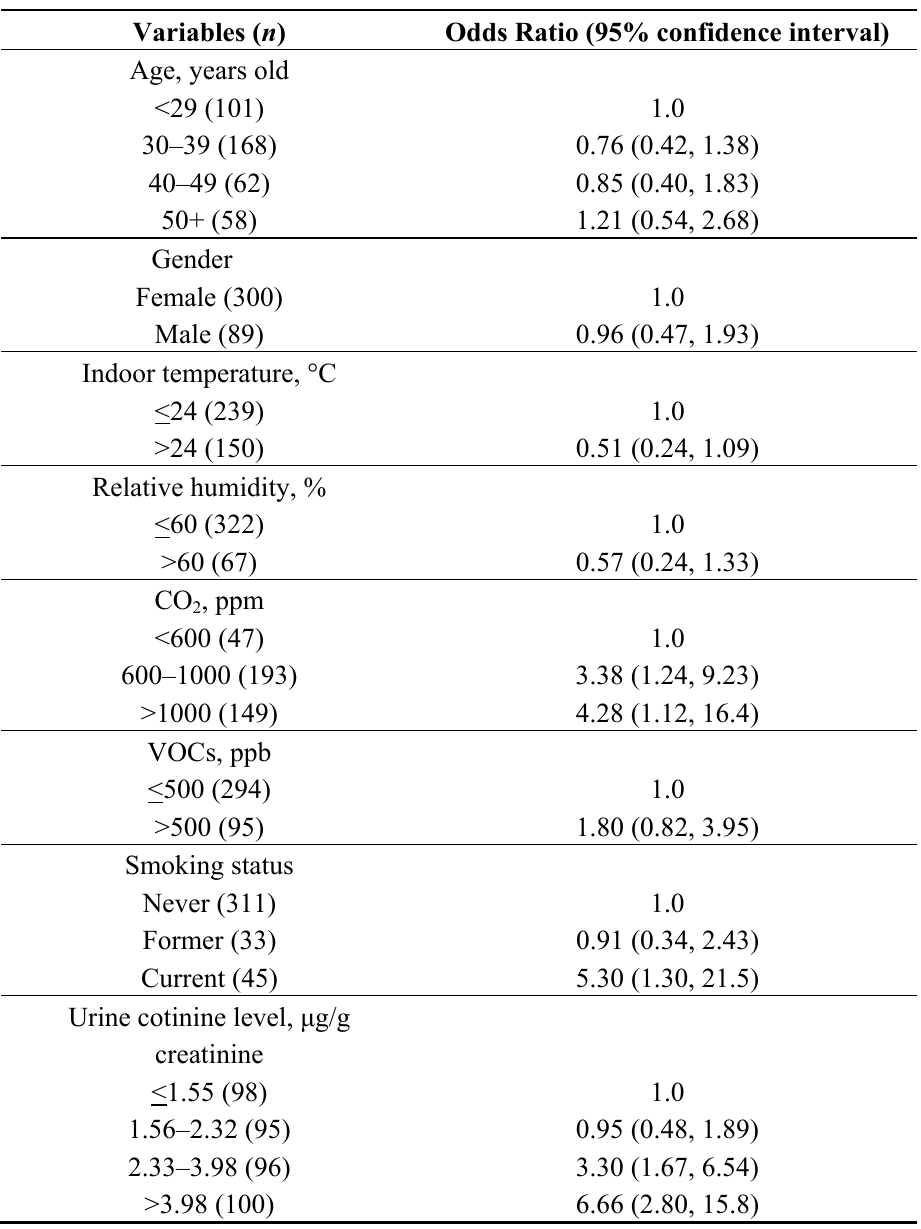
Table 2. Odds ratio of having urine 8-hydroxydeoxyguanosine (8-OHdG) greater than median, 4.99 μ g/g creatinine, by age, gender, temperature, relative humidity, the concentration of indoor carbon dioxide and volatile organic compounds, smoking status and urinary cotinine, ( N =